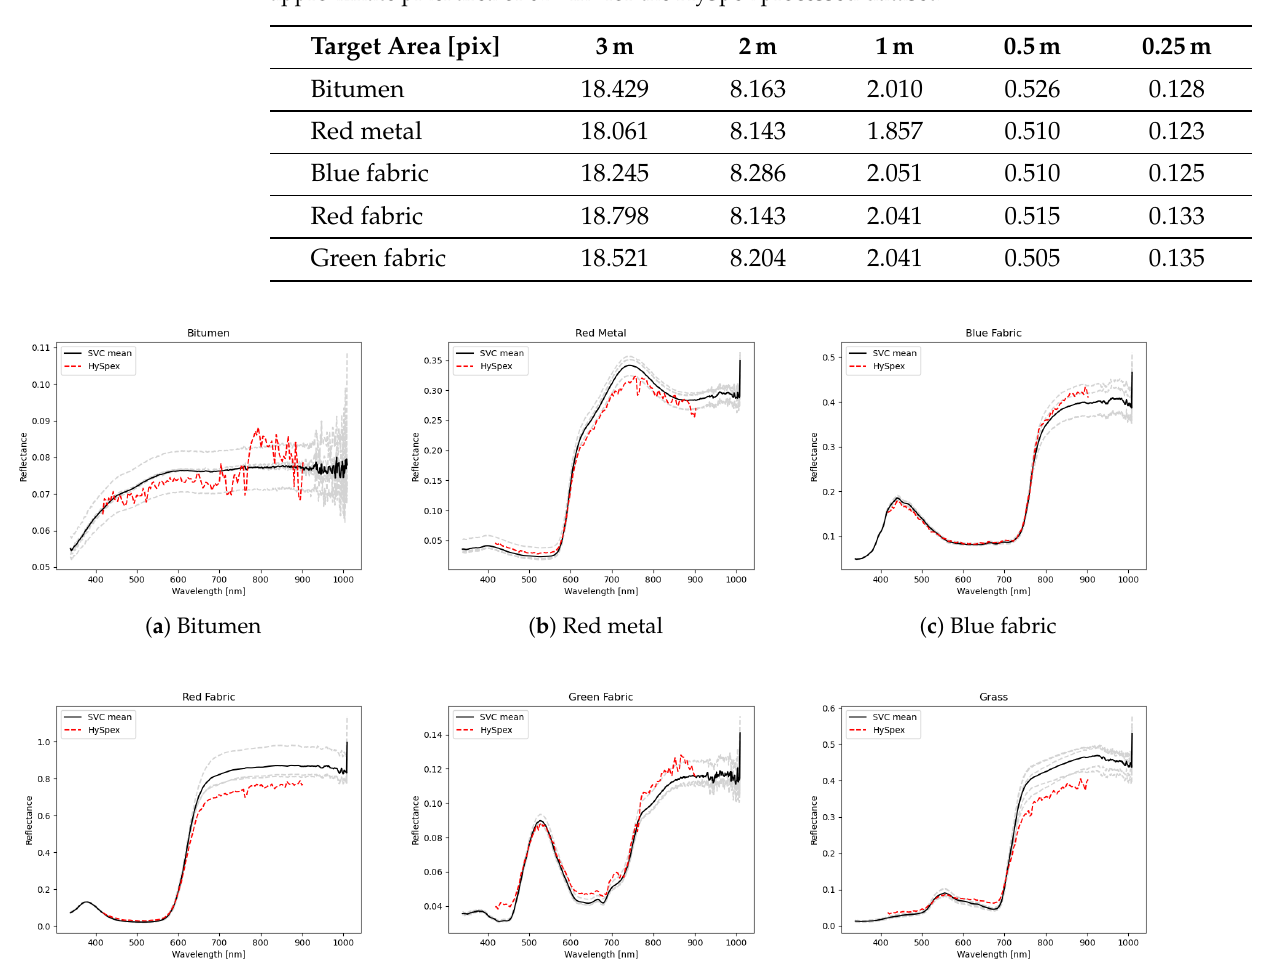
Table A2. Target areas in units of pixels. The areas in this table were derived from Table A1 using the approximate pixel area of 0.7 2 m 2 for the HySpex processed dataset.